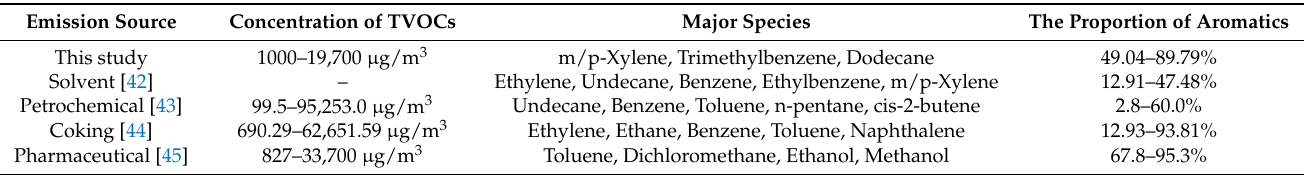
Table 5. Comparison with VOCs emitted by other typical